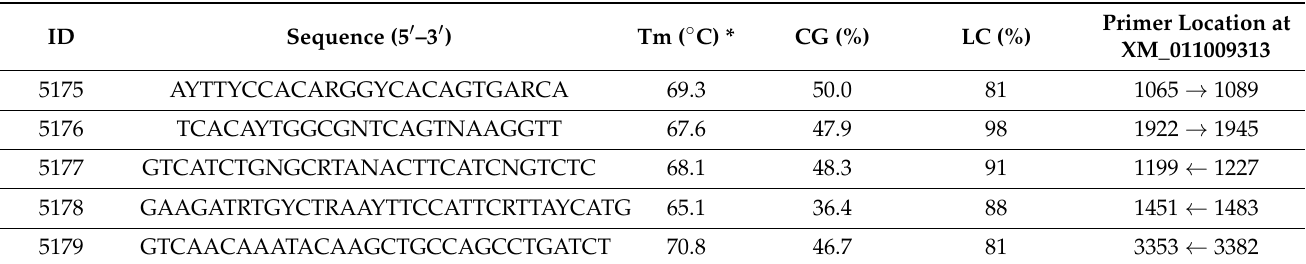
Table 6. Universal primers used in the analysis of polymorphisms of allelic variations of auxin response factor gene families using multi-locus EPIC-PCR profiling.